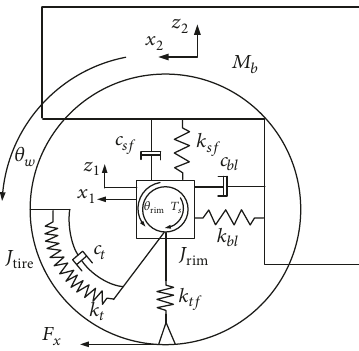
Figure 4: Model of tire and its connection with vehicle body.